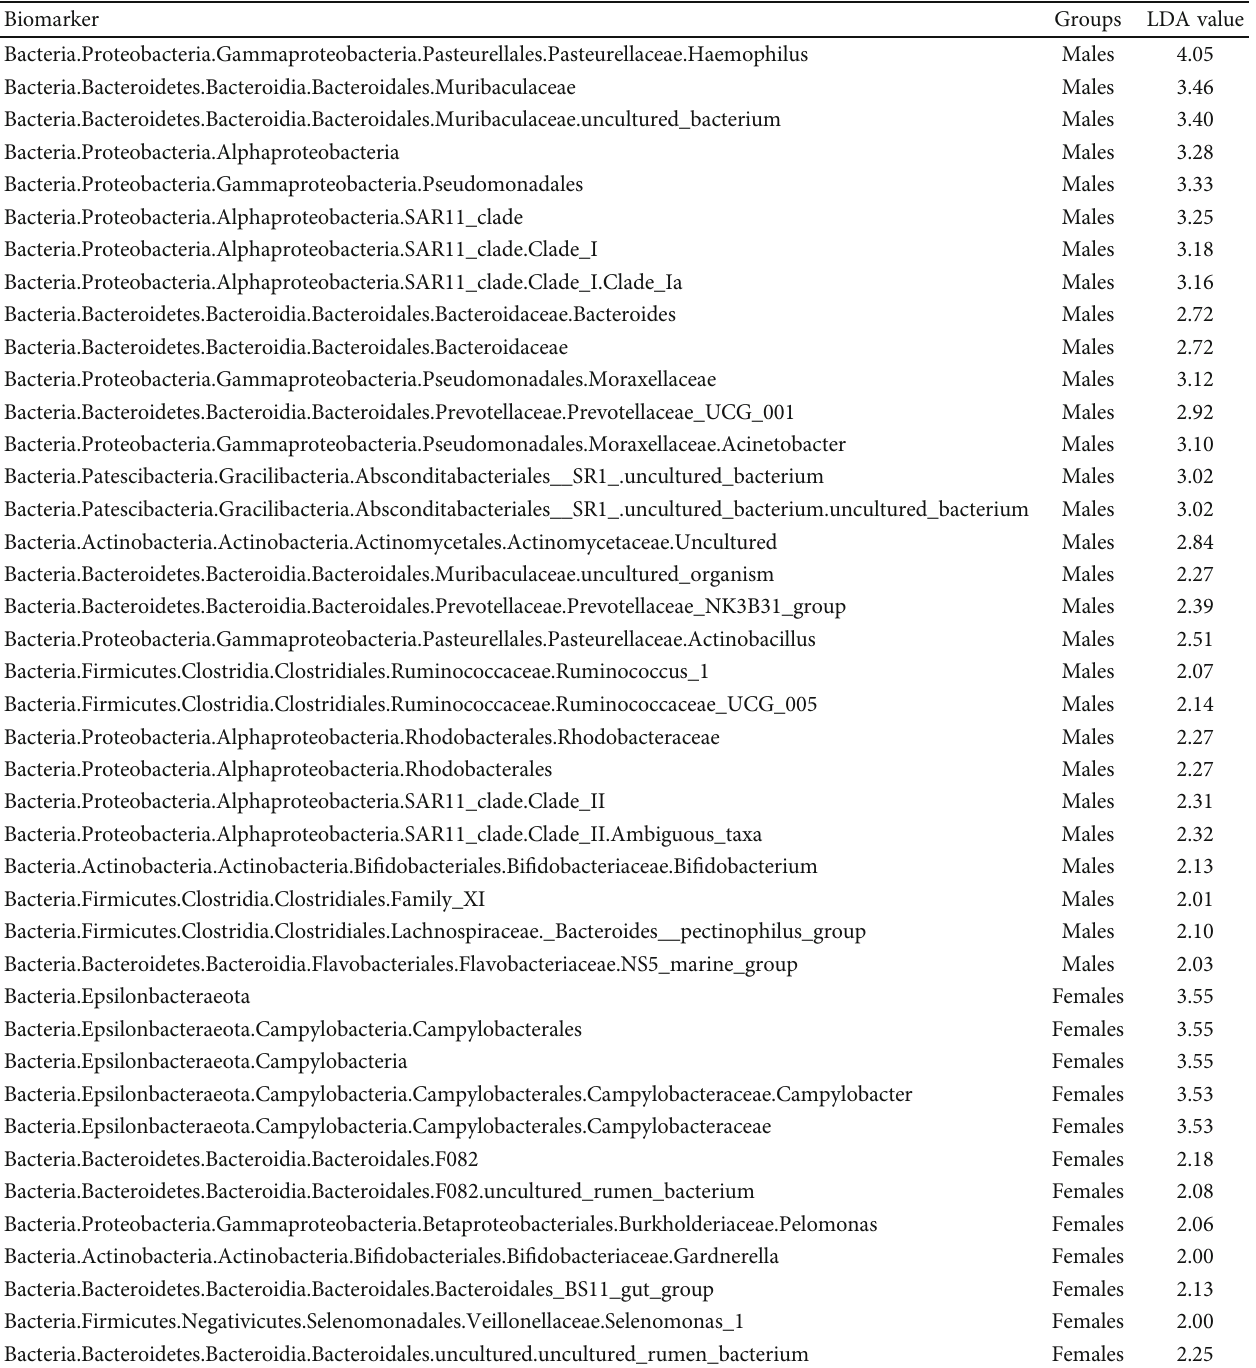
Table 2: Linear discriminant analysis (LDA) e ff ect size (LEfSe) results of the distinct taxa between males and females.